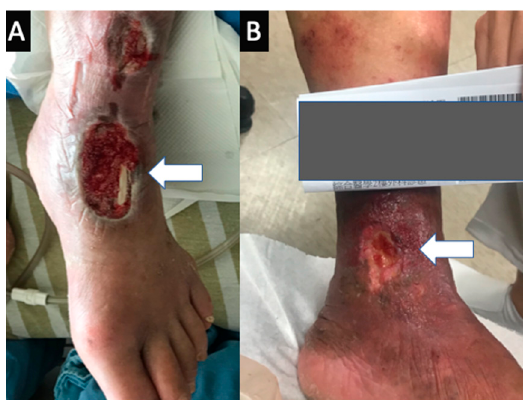
Figure 1. Typical stasis leg ulcer in the gaiter area. ( A ) Wet and nonhealing stasis leg ulcer with tendon exposure. This patient has no co-existed arterial nor connective tissue disorder. ( B ) Stasis leg ulcer with skin discoloration and granulation at the ankle. Typical stasis leg ulcer in the gaiter area.